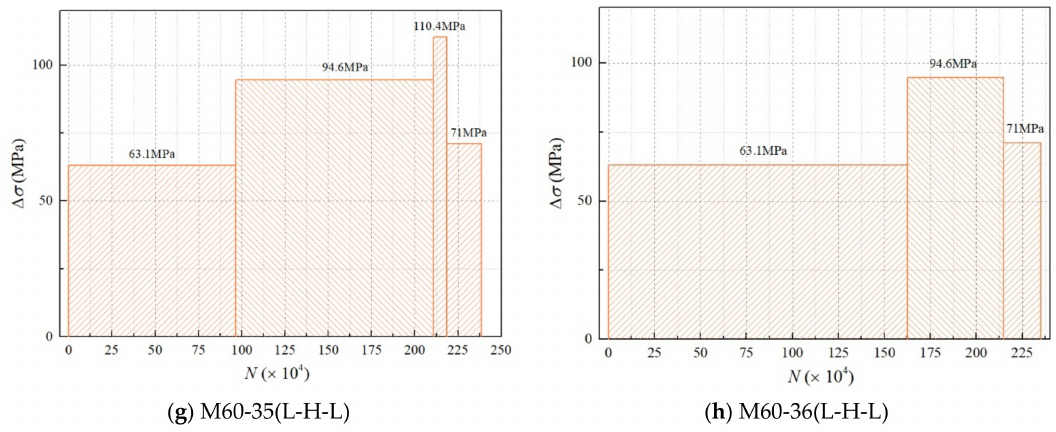
Figure 6. The stress histogram of M60 high-strength bolts under variable-amplitude loading.